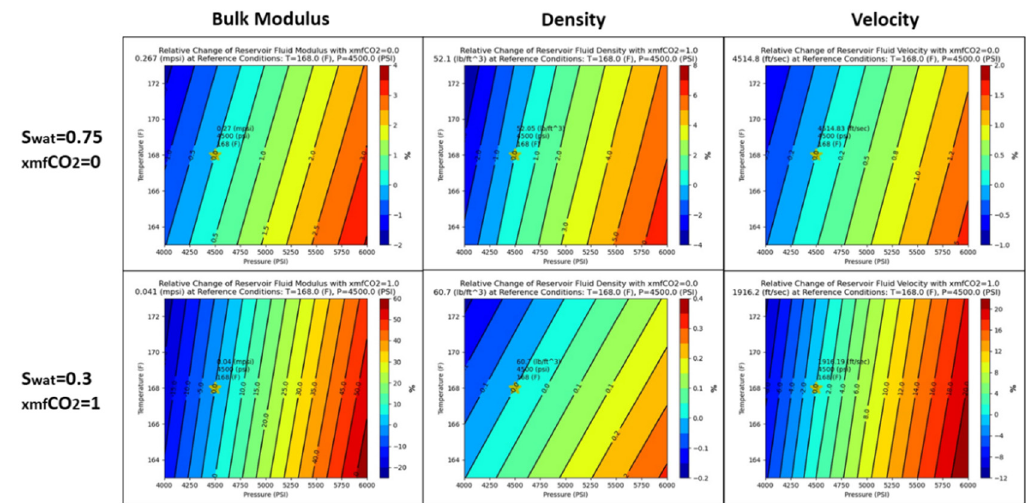
Figure 15. Contoured variations of fluid bulk modulus ( left ), density ( center ), and velocity ( right ) vs. temperature and pressure for stiffest fluid mix ( top ) and softest fluid mix ( bottom ). Contours are percent change relative to reference points shown.